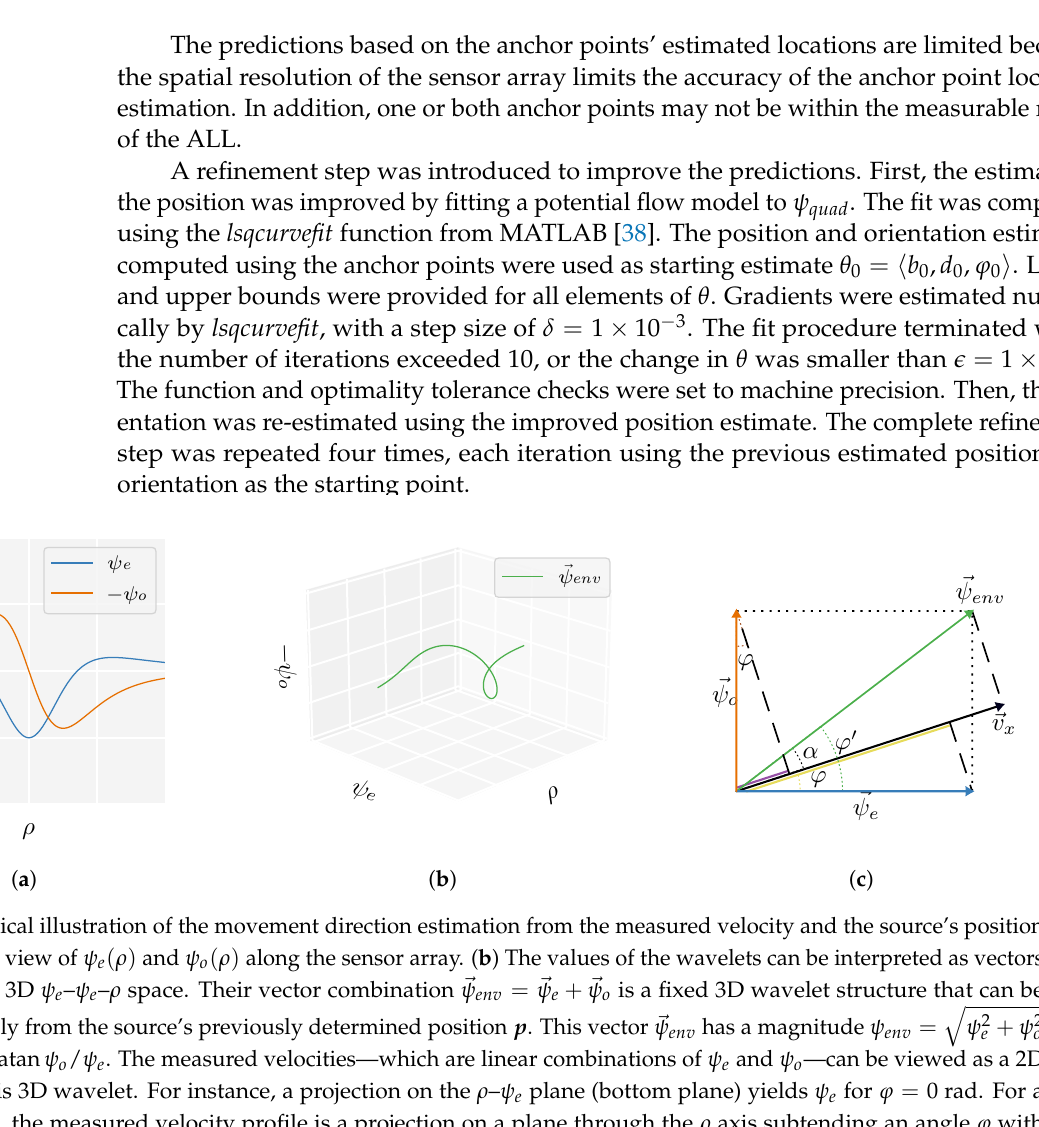
(cid:113) ψ 2 e + ψ 2 o